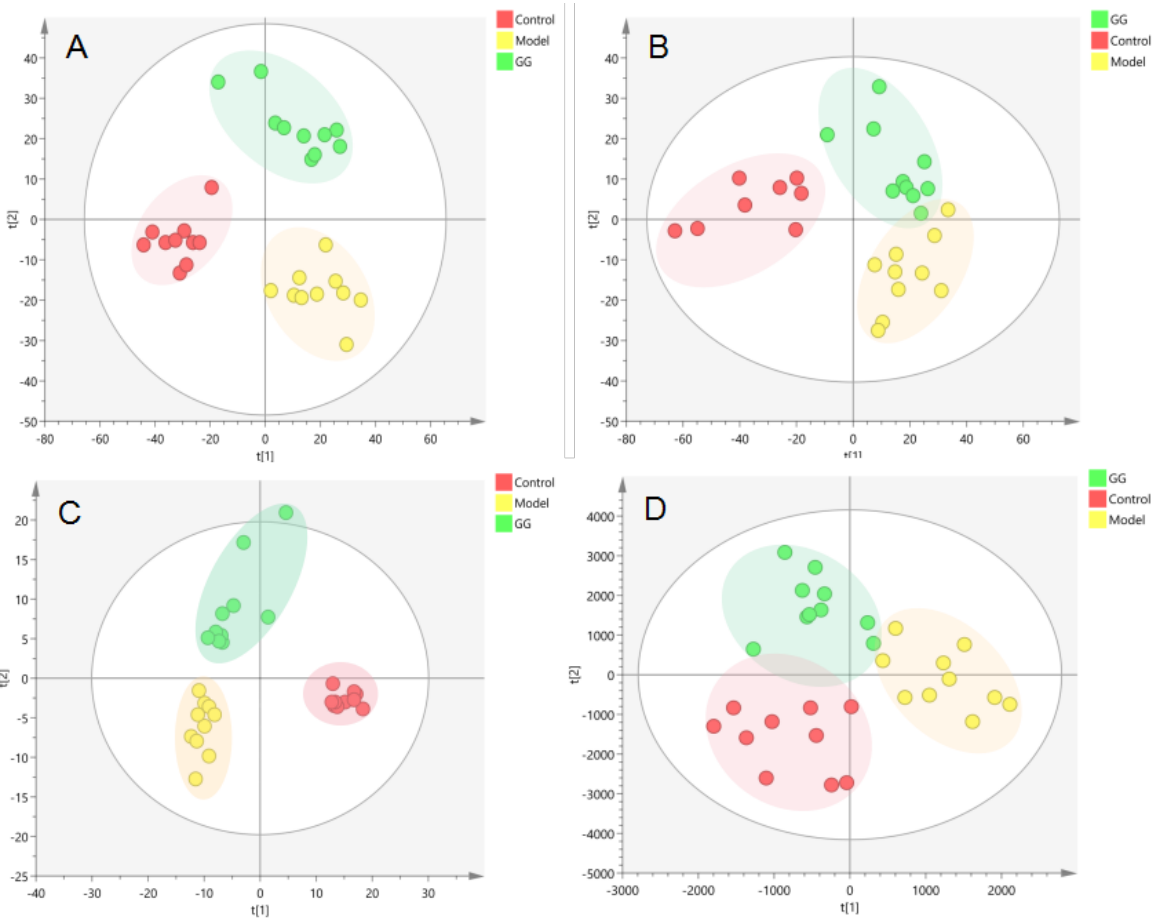
Figure 9. Metabolic profile in the serum of the T2D db/db mice treated with GG polysaccharide (( A ). NEG, PCA; ( B ). POS, PCA; ( C ). NEG, PLS-DA; ( D ). POS,